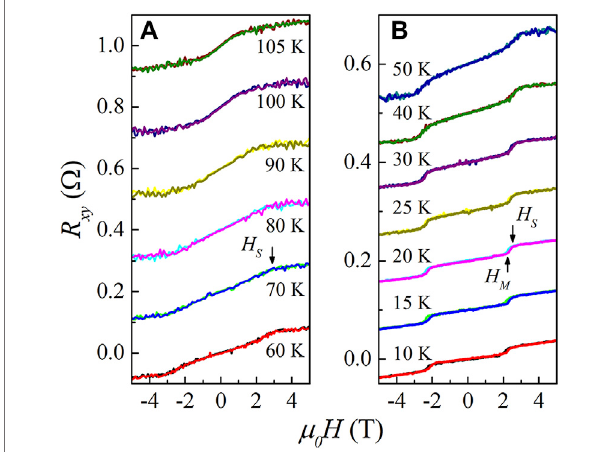
FIGURE 2 | (A) and (B) Hall resistance R xy of the 45-nm-thick